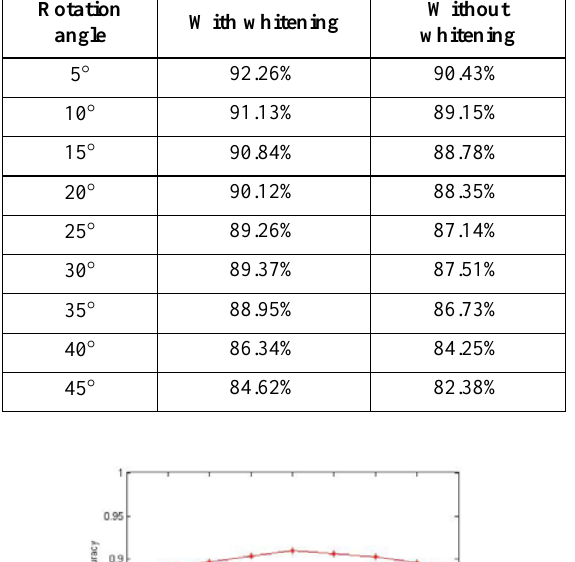
Table 2. Rotation detection accuracy